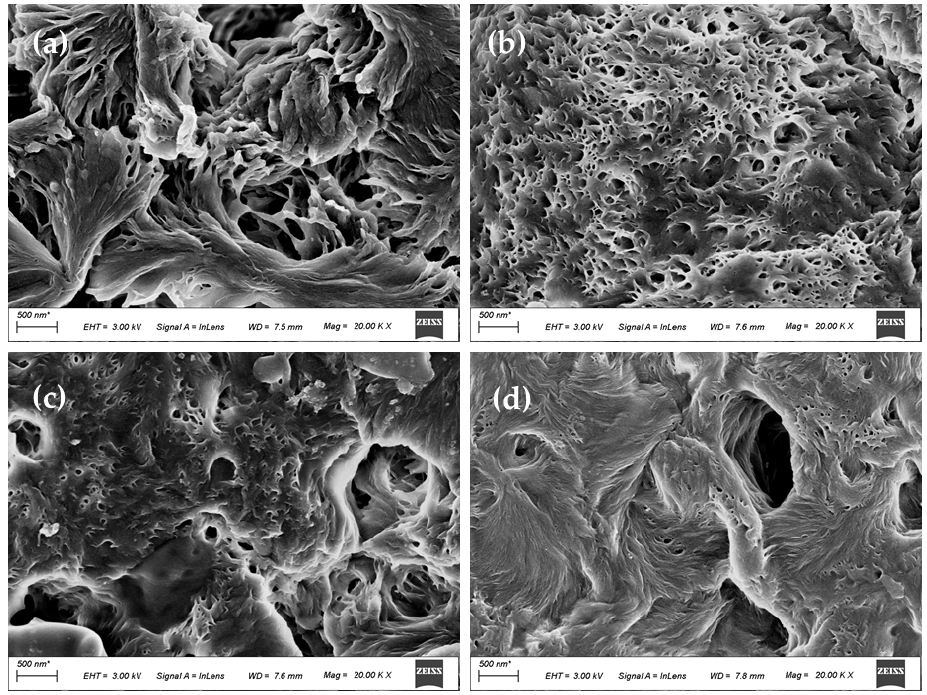
Figure 9. SEM images of upper surfaces of PA66 and PA66/GO membranes, ( a ) P0, ( b ) P1, ( c ) P2 and ( d ) P3.